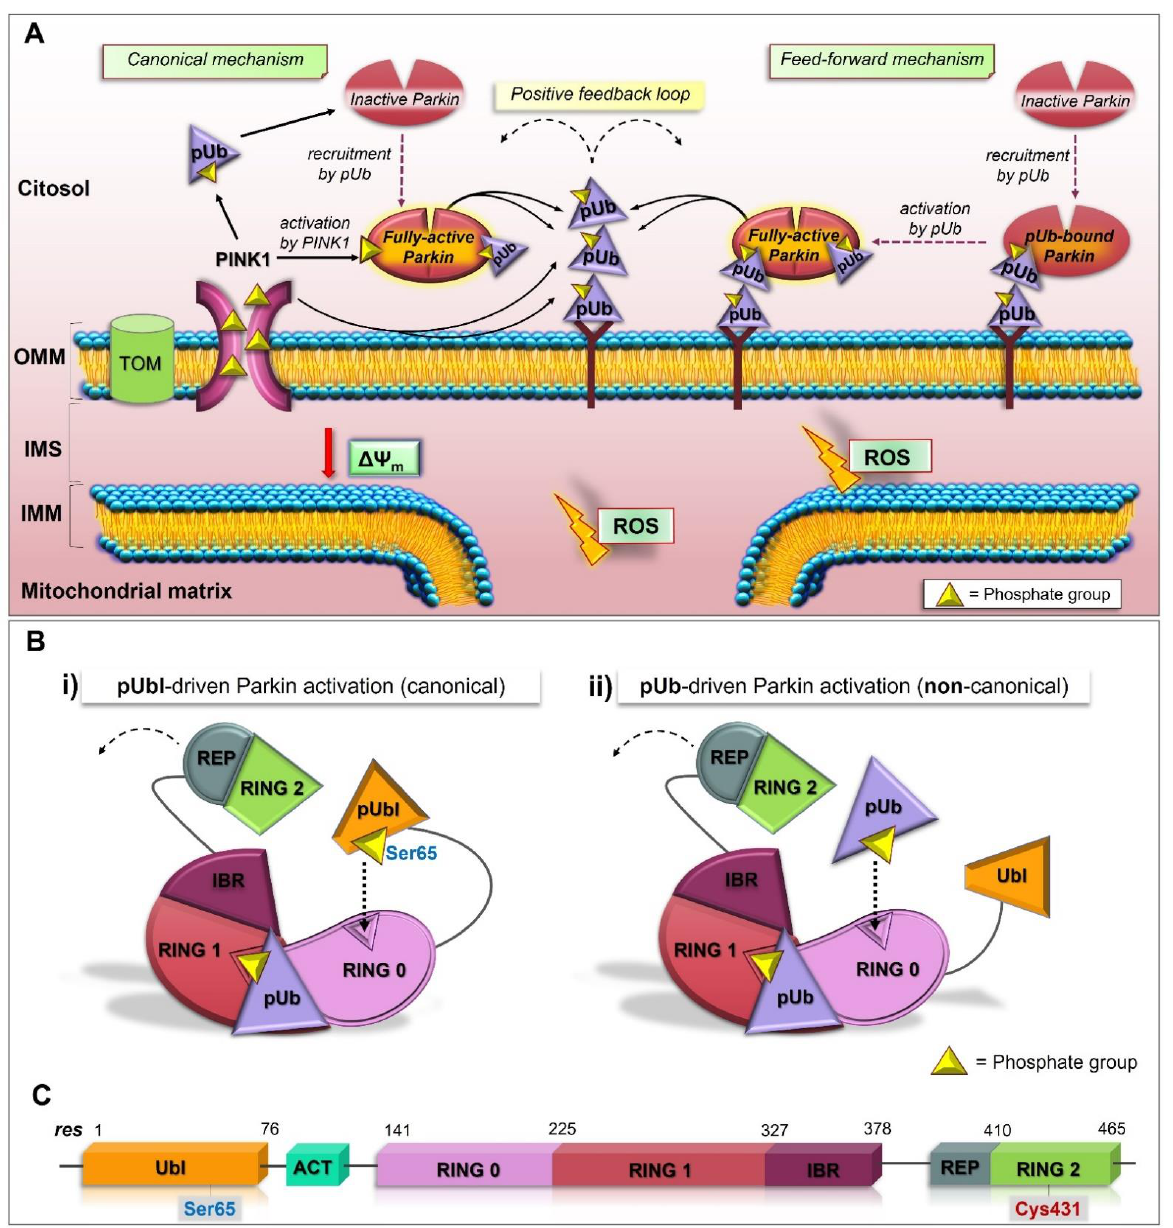
Figure 1. A working model representing simultaneous canonical and feed-forward mechanisms of Parkin activation. ( A ) Canonical mechanism: PINK1 activates Parkin directly by phosphorylating Parkin Ubl domain at Ser65 and indirectly through phosphorylation of Ub proteins at Ser65, relieving the autoinhibition of Parkin ligase. This enables Parkin to poly-ubiquitinate substrates on the OMM. These chains are then phosphorylated by PINK1 and act as docking sites for further recruitment and activation of Parkin (positive feedback loop); feed forward mechanism: PINK1-mediated phosphorylation of Ub on damaged mitochondria leads to the recruitment of latent Parkin. A second pUb acts as a fixed activation signal of Parkin leading to the conformational rearrangements which release its autoinhibition. Parkin-mediated addition of new Ub on the OMM gives rise to positive feedback cycle. OMM: outer mitochondrial membrane; IMS: intermembrane space; IMM: inner mitochondrial membrane. ( B ) Mechanisms of Parkin activation. ( i ) pUbl- or ( ii ) pUb-binding